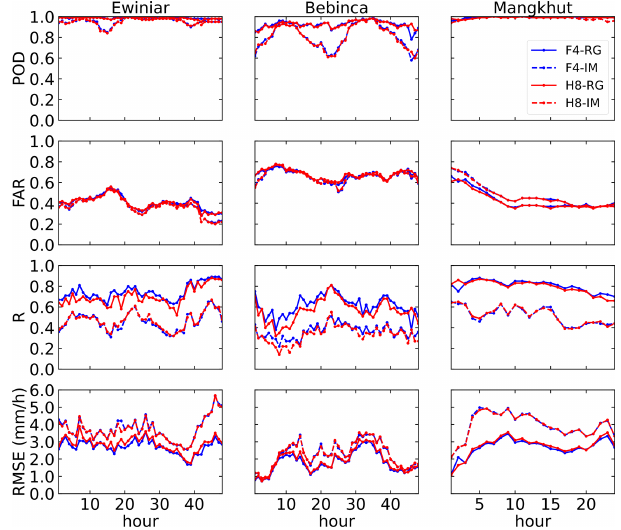
Figure 12. Time series plots of the POD, FAR, R and RMSE (mmh − 1 ) from F4-RG, H8-RG, F4-IM and H8-IM throughout the evolution of the three typhoon